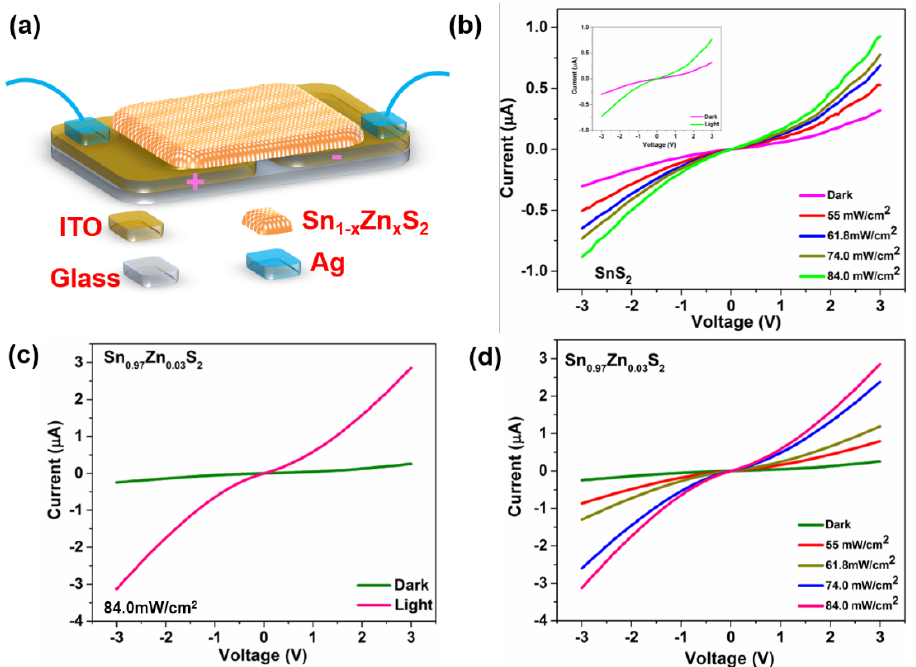
Figure 8. ( a ) Schematic representation of the photoelectronic device. ( b ) I-V characteristics of SnS 2 device under different illumination intensities (Inset shows the I-V characteristics under dark and illumination intensity 84.0 mW/cm 2 ). ( c ) I-V characteristics of Sn 0.97 Zn 0.03 S 2 device under illumination conditions. ( d ) I-V characteristics of Sn 0.97 Zn 0.03 S 2 device under different light intensities (55, 61.8, 74.0, 84.0 mW/cm 2 ).